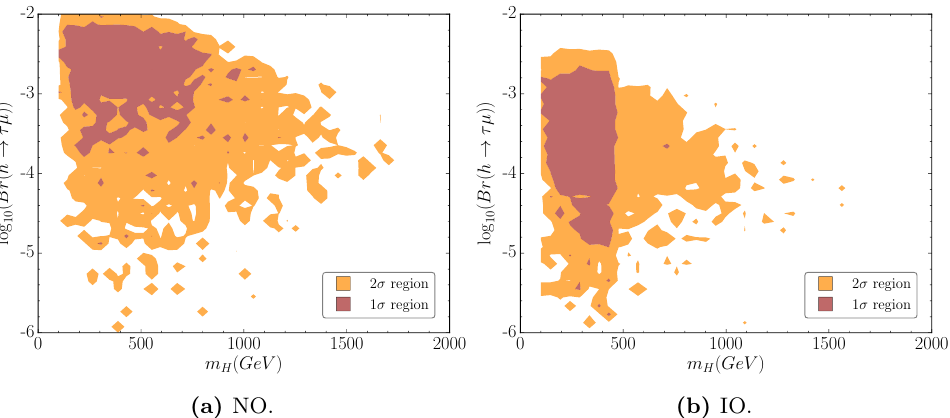
(cid:28)(cid:22) ) for (a) (cid:22) = 0, !